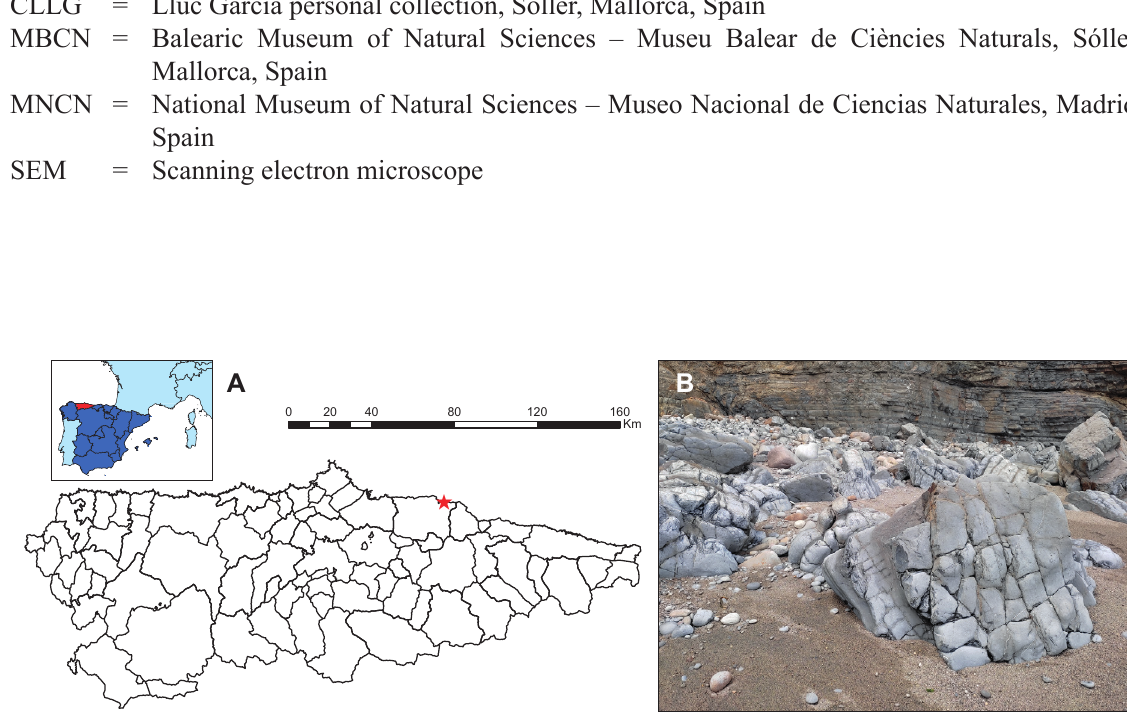
Fig. 1. A . Type locality of Buchnerillo atlanticus sp. nov. ( ★ ) in Asturias (red), Spain (dark blue). B . Habitat of Buchnerillo atlanticus sp. nov. in Conejera beach (Villaviciosa,